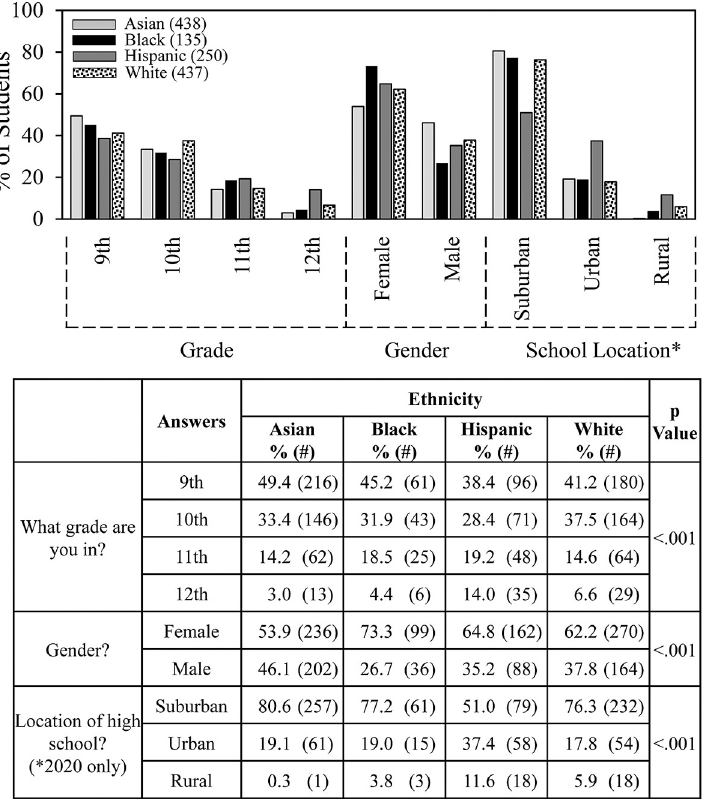
Fig 2. Ethnicity and student